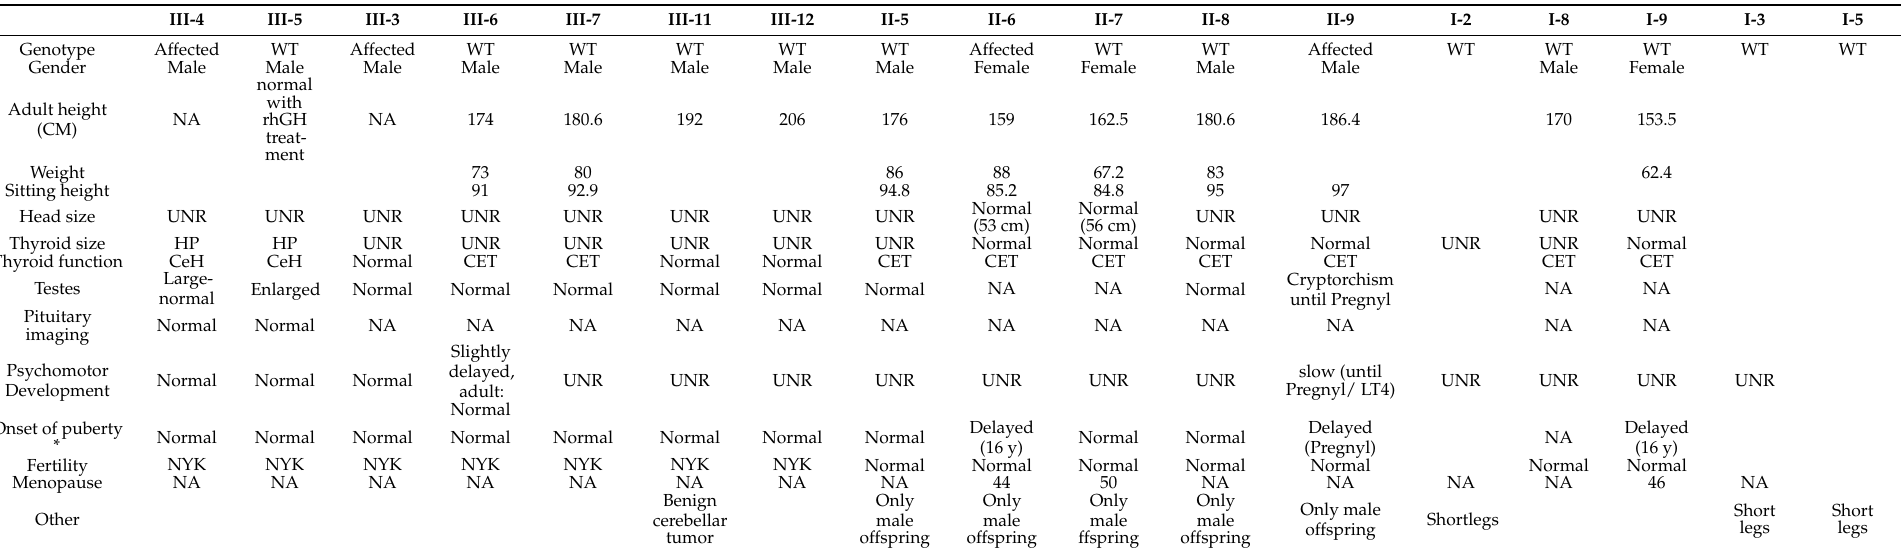
Table 5. Overview of clinical features of the two brothers with a p.C947R variant and their first- and second-degree